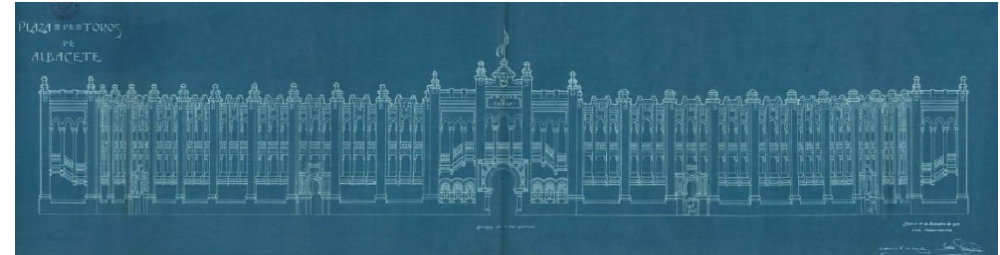
Figure 7. Design of the bullfighting ring (1916). Albacete. © Archivo Histórico Provincial de Albacete.